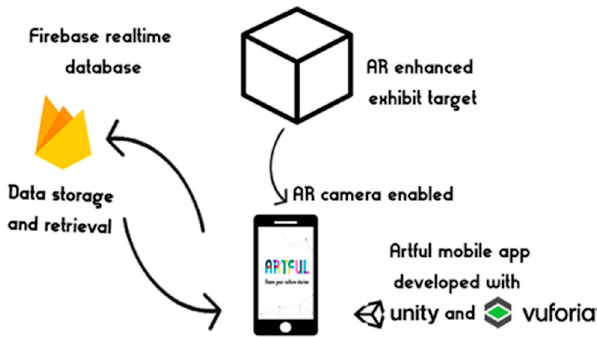
Figure 3. ARtful mobile app’s technological framework.